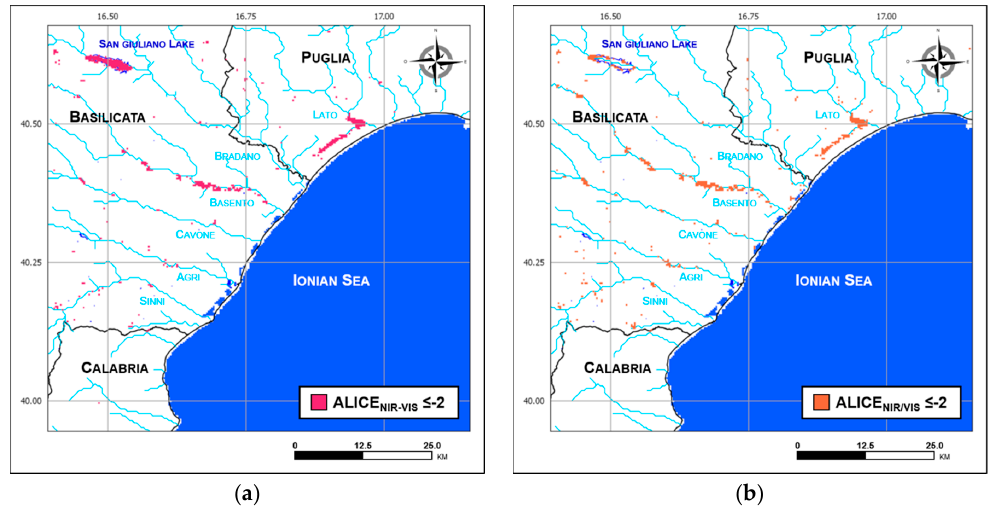
Figure 8. ( a ) Flooded areas detected within the Region of Interest (ROI) by integrating results achieved by ALICE NIR-VIS implemented on MODIS and VIIRS data for the two investigated days; ( b ) as in ( a ) using the ALICE NIR/VIS